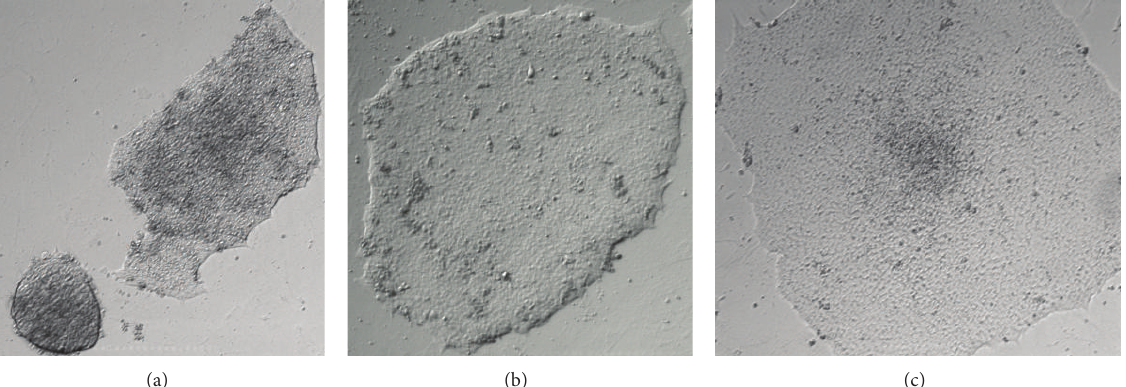
Figure 2: hESCs were grown on nonfixed ECM or methanol fixed xeno-free ECM in mTeSR1. (a) hESCs were grown on nonfixed xeno-free ECM in mTeSR1; (b) hESCs were grown on 80% methanol fixed xeno-free ECM in mTeSR1; (c) hESCs were grown on 100% methanol fixed xeno-free ECM in